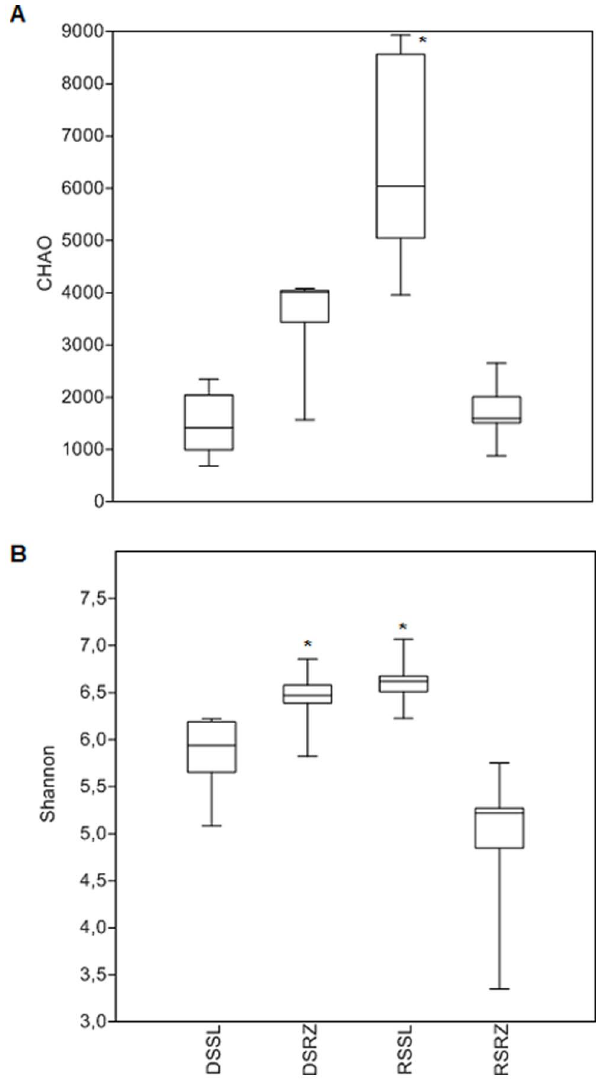
Figure 4. Estimation of total species richness obtained by the Chao index (A) and diversity using the Shannon-Wiener index (B) for samples from bulk soil during the dry season (DSSL), rhizosphere during the dry season (DSRZ), bulk soil during the rainy season (RSSL) and rhizosphere during the rainy season (RSRZ). Significant values according to Tukey’s test (p , 0.01) are indicated by an *.